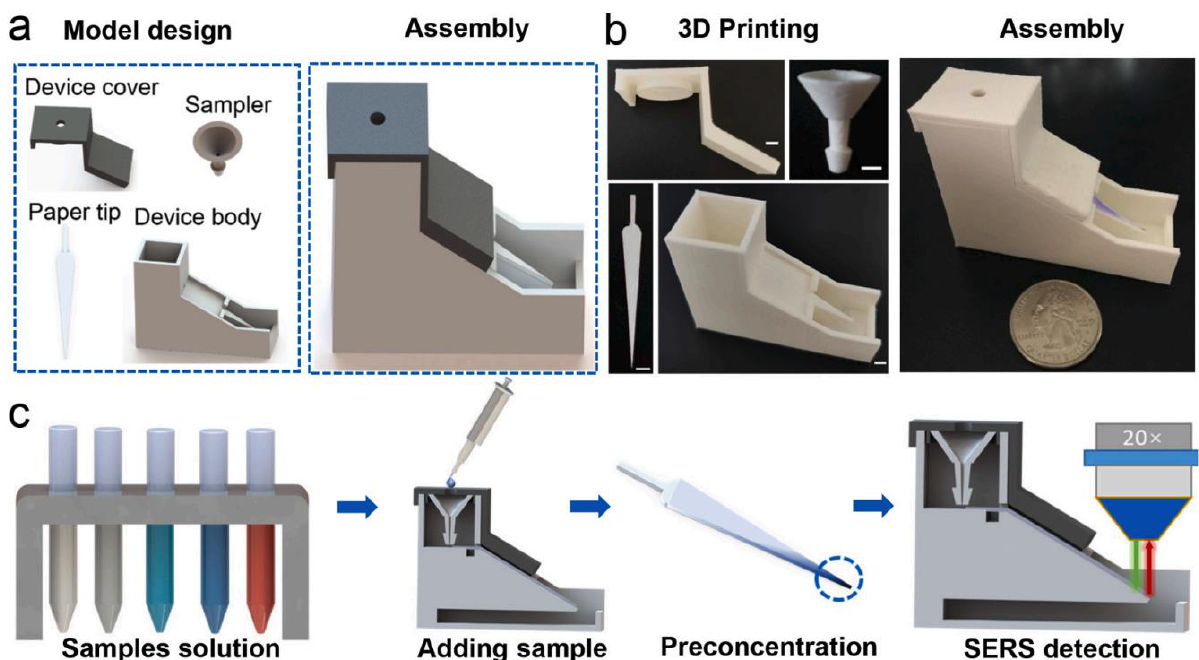
Figure 3. ( a ) Design schematic of 3D-printed paper cartridge. ( b ) Photograph of the paper cartridge’s fabrication process. (Scale bars are 4 mm). ( c ) Integrated detection procedure of the paper cartridge. Reproduced with permission from Cheng et al. [23], Biosensors and Bioelectronics, 189, 113266. Pub- lished by Elsevier, 2021.